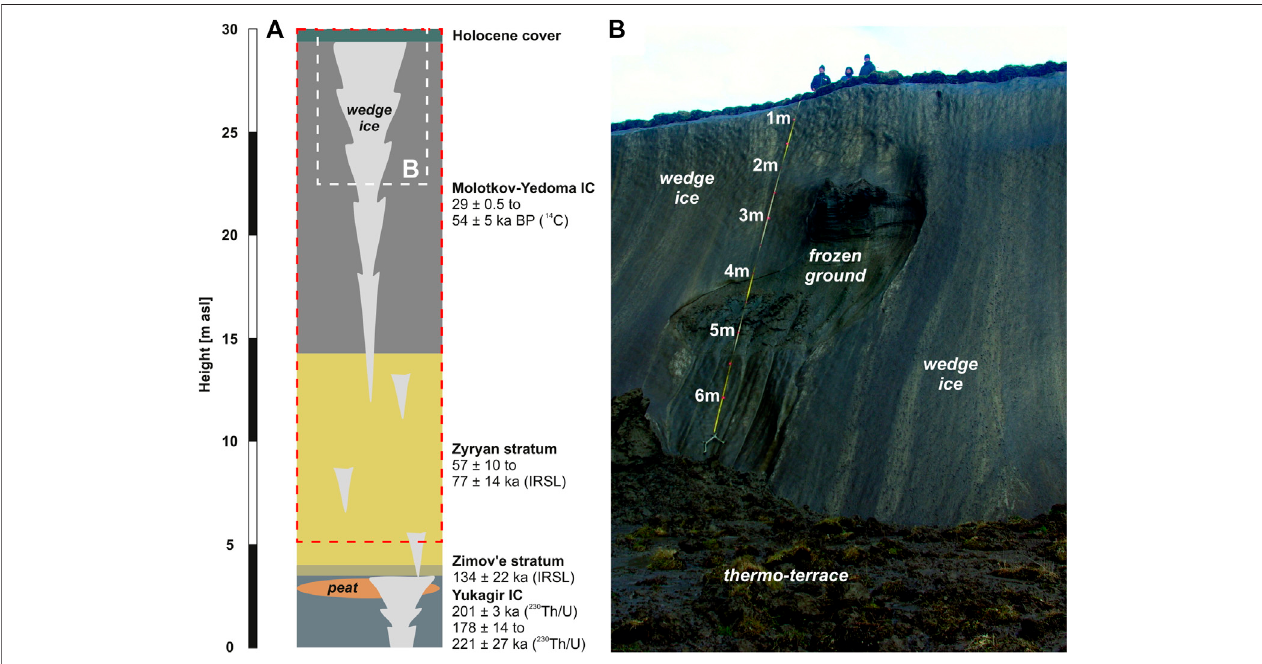
FIGURE 2 | (A) Major stratigraphic sequences at our survey site as also summarized in Supplementary Table S1 . The red box denotes the depth range as covered by our GPR data and the white box indicates (B) the exposed uppermost 7 m of the Holocene cover and the Yedoma Ice Complex above a thermo-terrace.